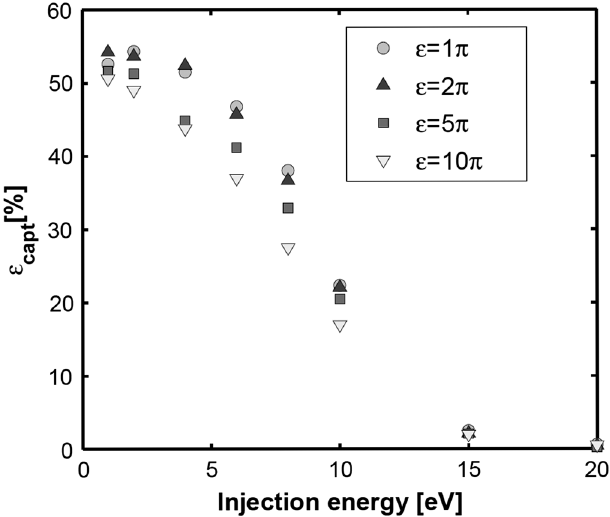
FIG. 6. Normalized ions captured as a function of the injection energy inside the charge breeder for different values of the injected beam rms transverse